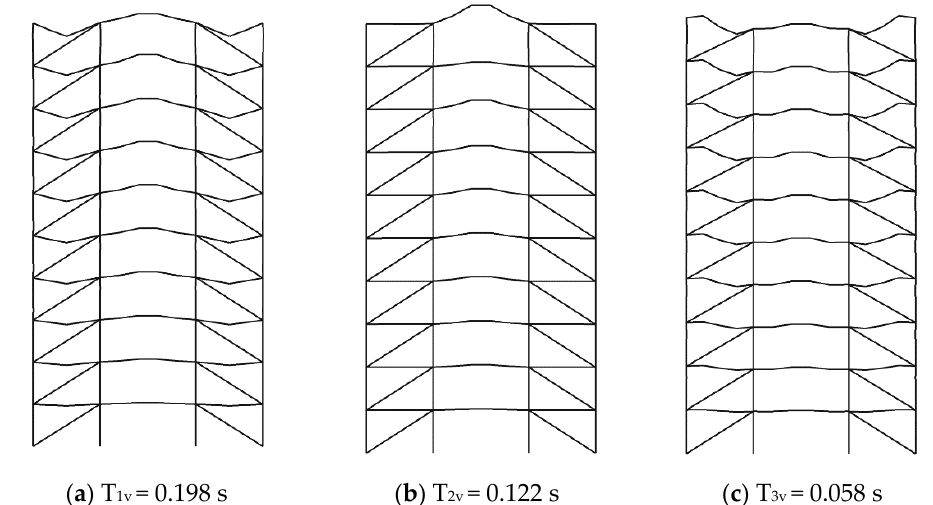
Figure 5. Vertical vibration modes for the ten-story building. Table 1. Mexican ground motions used for the frames in Figure 1